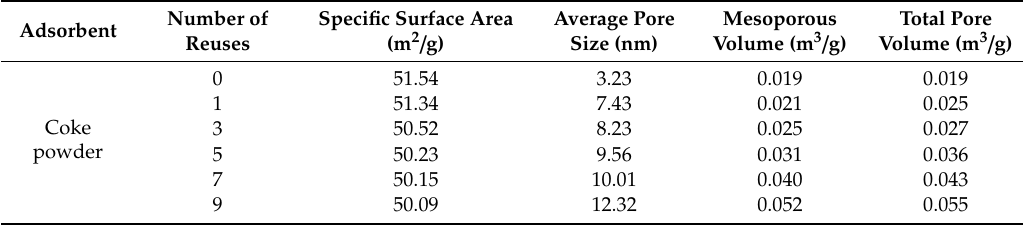
Table 5. BET analysis of coke powder before and after heat treatment.